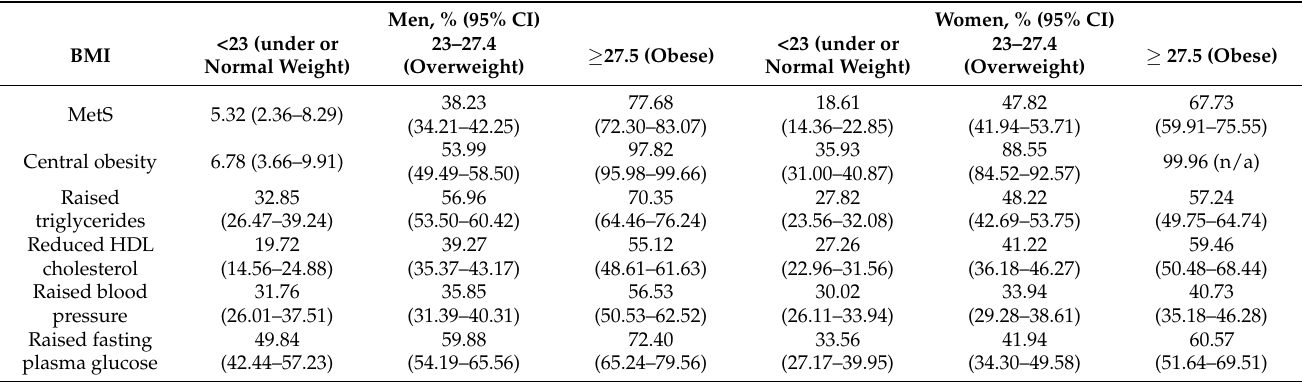
Table 3. Age-adjusted, sex-specific prevalence of MetS and individual components by BMI level in Asian Americans, NHANES 2011–2016 ( n =